Question: Write a single sentence explaining what this figure depicts.
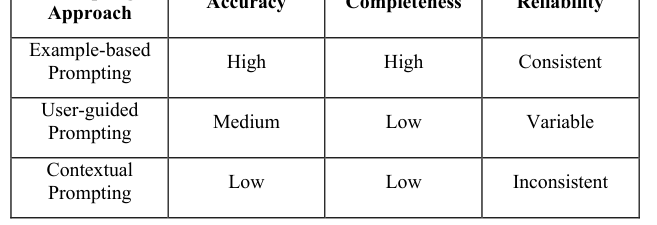
Answer: Performance Summary of Prompting Approaches